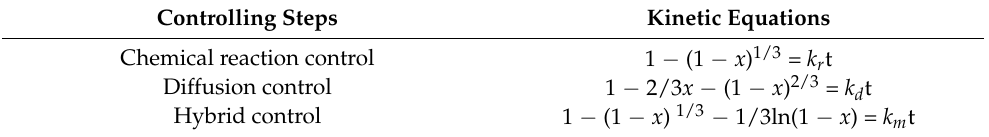
Figure 10. Volatilization rates of arsenic under different roasting temperatures and roasting times. Table 2. Kinetic equations of the SCM. Controlling Steps